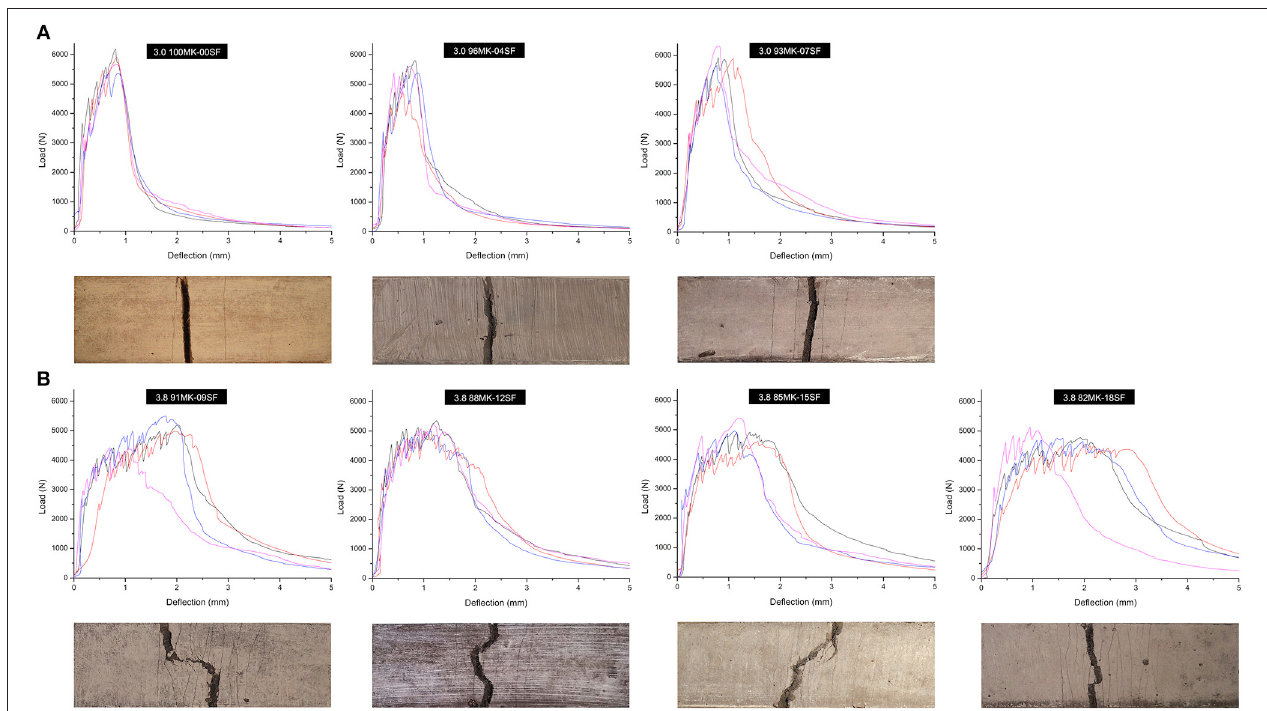
FIGURE 7 | Load (N) Deflection (mm) curves and cracked specimens of mortars with [SiO 2 ]/[Al 2 O 3 ] ratio equal to (A) 3.0 and (B) 3.8. × with solution/binder ratio of 1.02 has double the toughness of